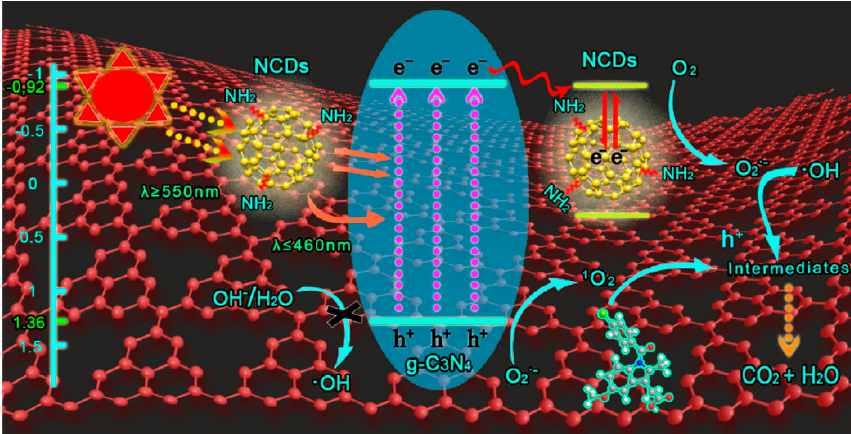
Figure 12. Schematic illustration of the possible photocatalytic processes in NCD / g-C 3 N 4 composites (reproduced with permission from [90]. Copyright Elsevier, 2017).